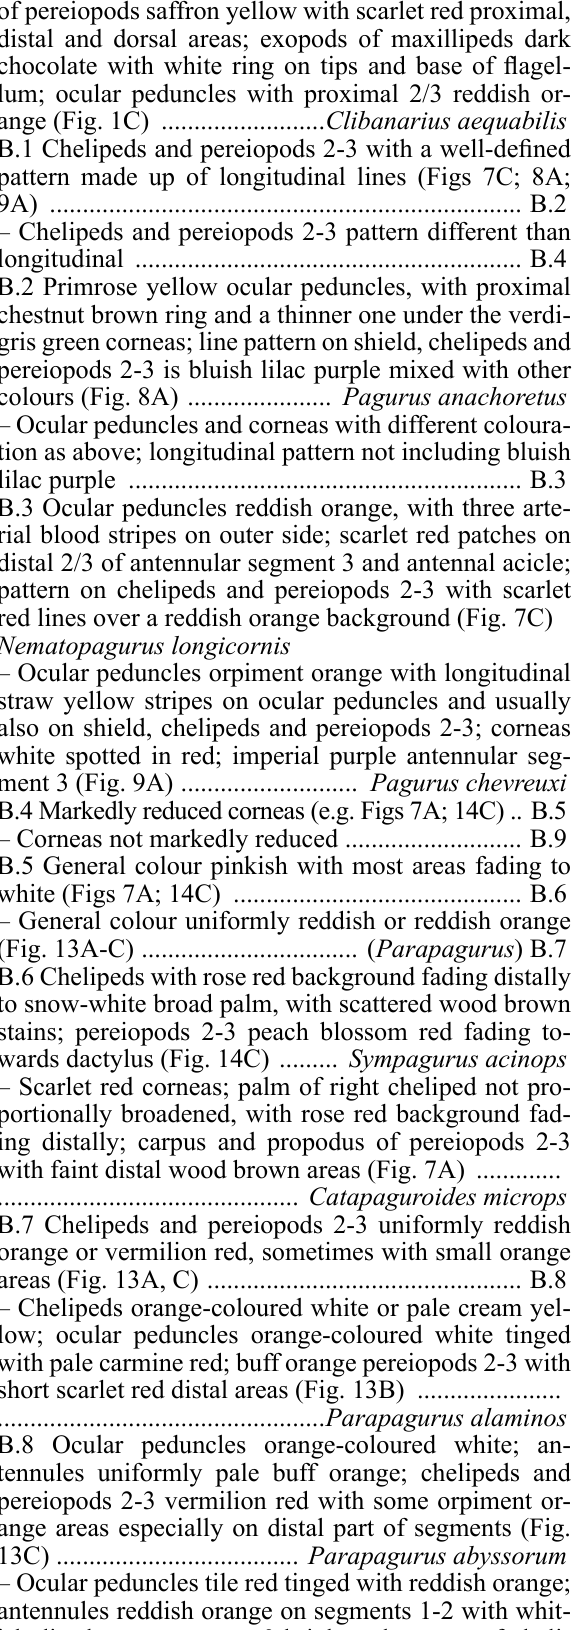
with transversal stains, not only longitudinal ..... B.18 B.18 Corneas outlined and spotted in gamboge